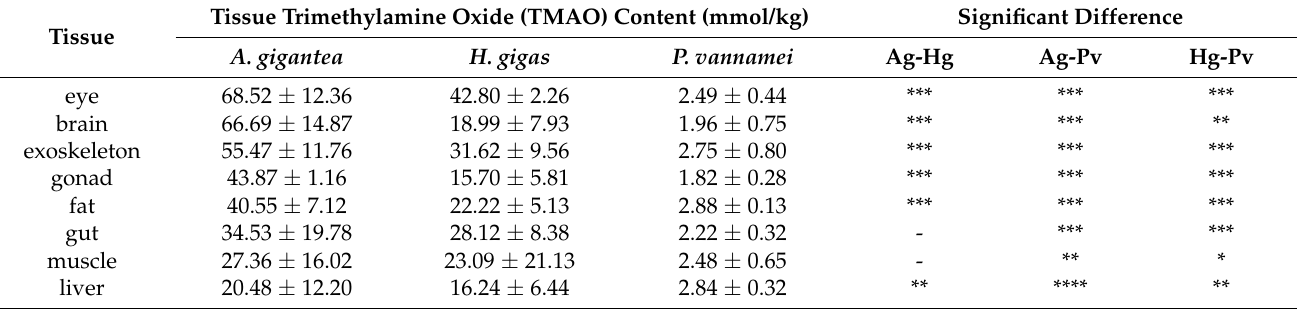
Table 1. The trimethylamine oxide (TMAO) content (unit: mmol/kg wet weight; mean ± SD) across eight tissues in three species.